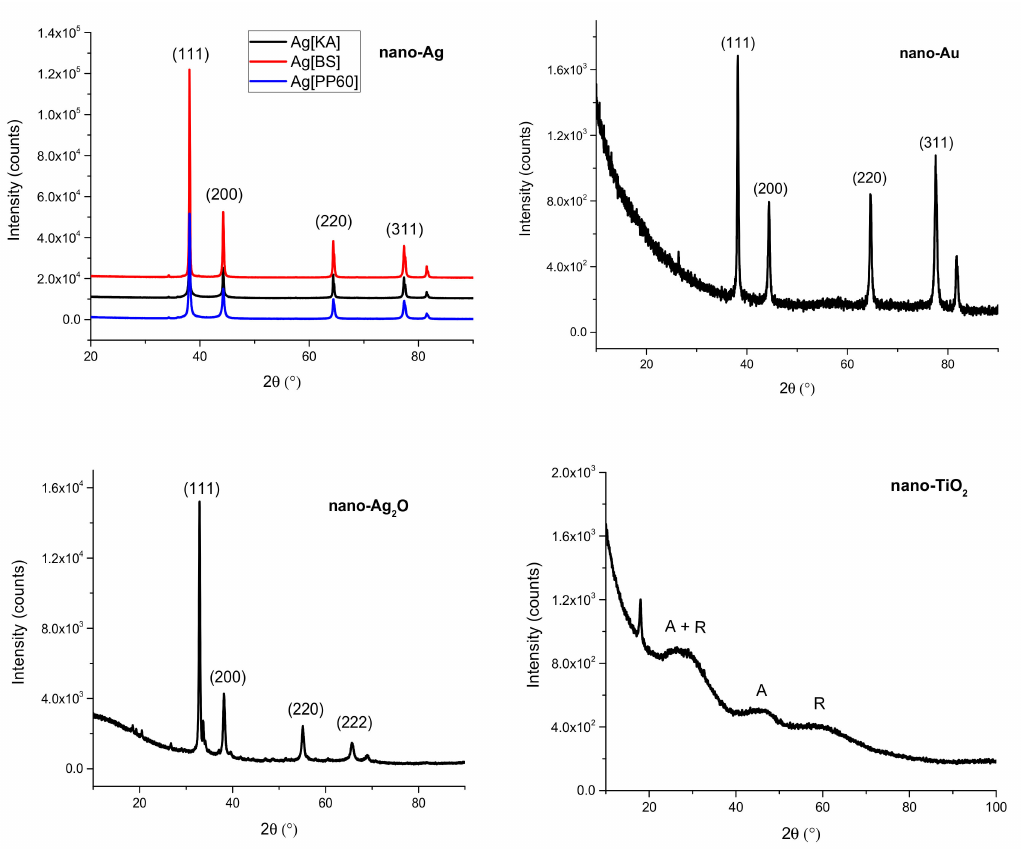
Figure 6. X-ray di ff raction (XRD) spectra of nano-Ag—Ag[KA], Ag[BS], and Ag[PP60]—nano-Au, nano-Ag 2 O, and nano-TiO 2